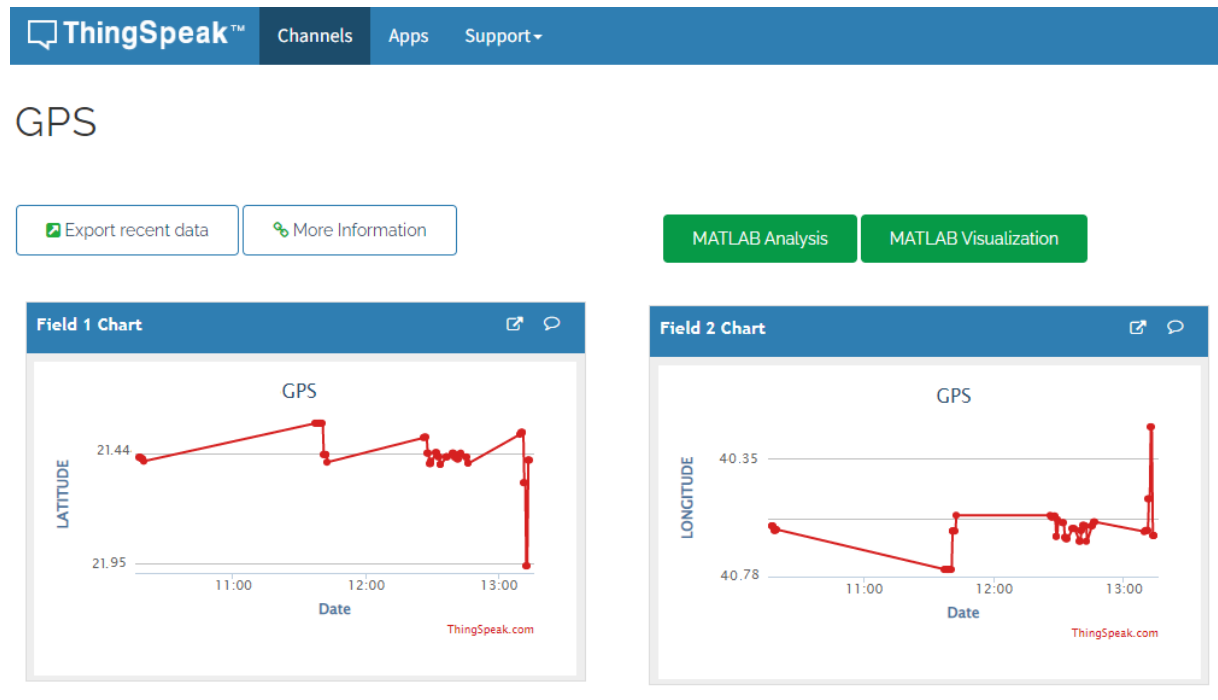
Figure 9. Vertical view using thermal camera to detect person at different altitudes: ( a ) 5 m, ( b ) 10 m, ( c ) 15 m.